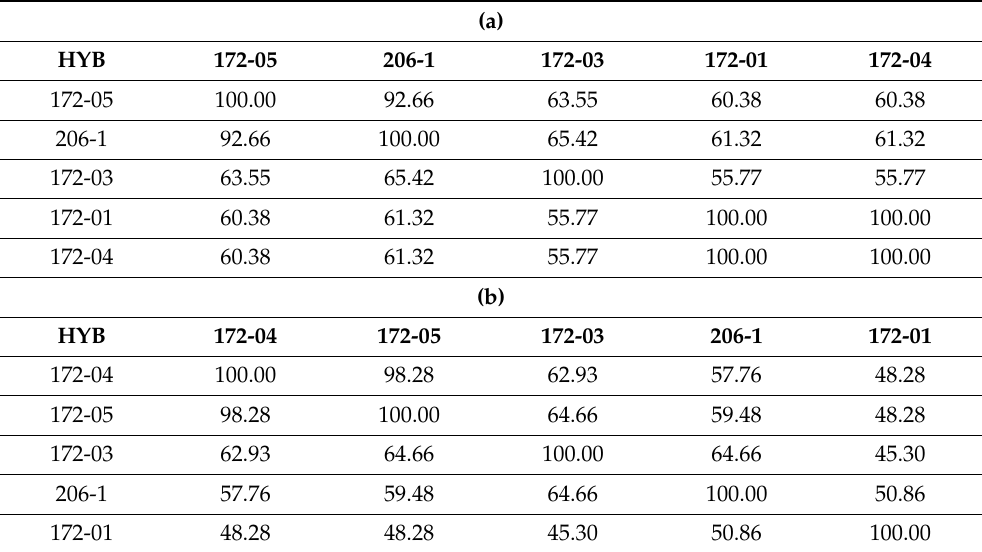
Table 3. Sequence similarity matrix for proteinase 3 monoclonal antibodies. ( a ). Heavy chains. ( b ). Light chains.